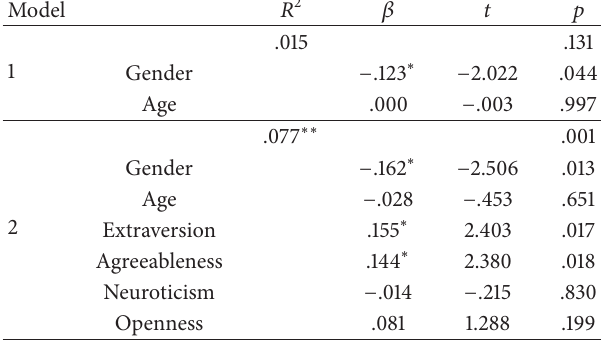
Table 3: Regression